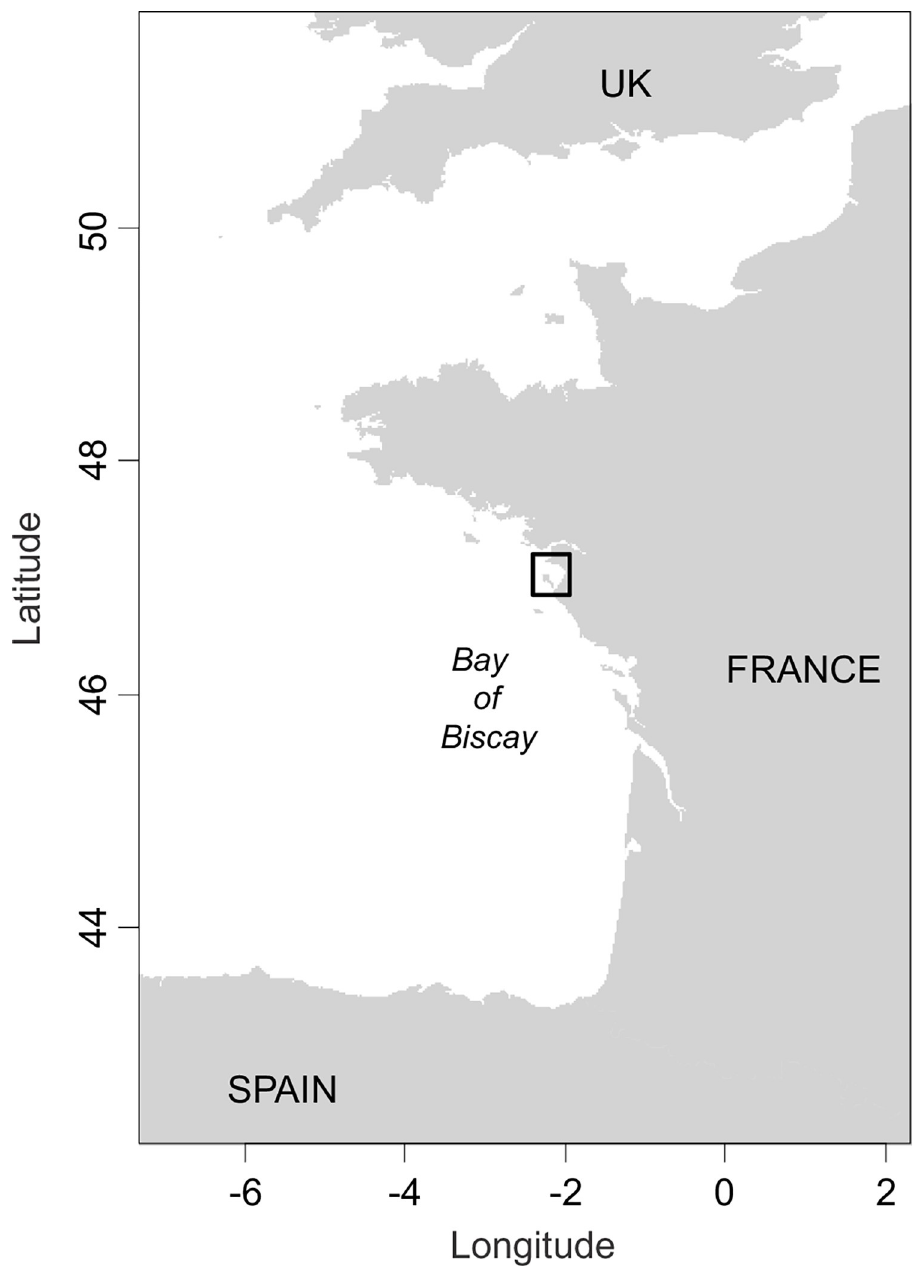
Fig 1. Map of the sampling location. The Bay of Bourgneuf, a shallow bay (from 0 to 34m depth) covering a relatively small area (320 km 2 ) is located within the Bay of Biscay (France, northeast Atlantic). following the classical δ notation, as deviation from international standards (Vienna Pee Dee Belemnite for δ 13 C and atmospheric N for δ 15 N). Data were normalized and checked using 2 internal lab standards (corn, trout, and deer) and instrument linearity was measured using a chemical standard (Methionine). Standard deviation on repeated measures was < 0.15 for δ 13 C and < 0.2 for δ 15 N. Samples were not acidified since calcified structures were mechani- cally removed during dissection and preparation (e.g. mollusk shell, decapod cuticle) and no